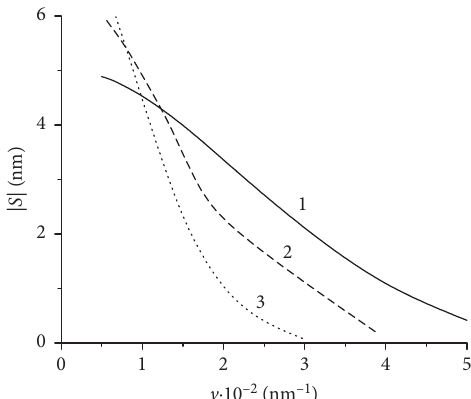
Figure 4: The contrast K of the evanescent field over the si- sin nusoidal quartz surface profile depending on the height of the Figure 5: The module of the spatial spectrum functions for the protrusions of this surface h at different spatial frequencies of the random surface profiles characterized by a Gaussian correlation profile ] : 0 . 8 · 10 − 2 nm − 1 (curve 1), 1 . 6 · 10 − 2 nm − 1 (curve 2), and function with a correlation length of σ � 14.2nm (curve 1), 4 · 10 − 2 nm − 1 (curve 3). σ � 23.7 nm (curve 2), and σ � 33.1nm (curve 3).